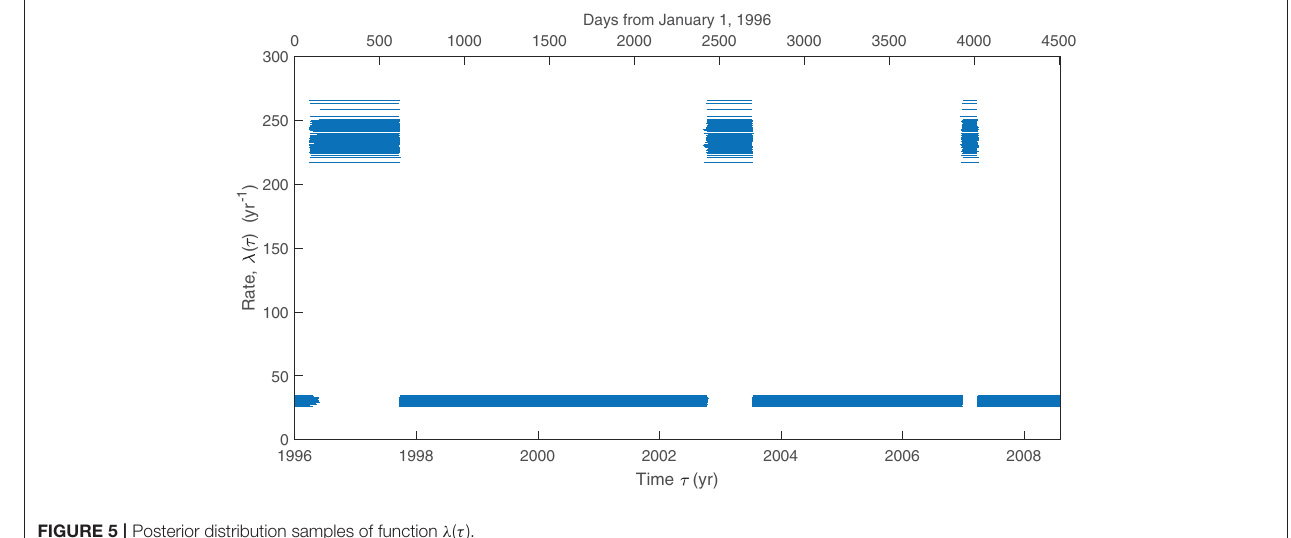
FIGURE 5 | Posterior distribution samples of function λ ( τ ).